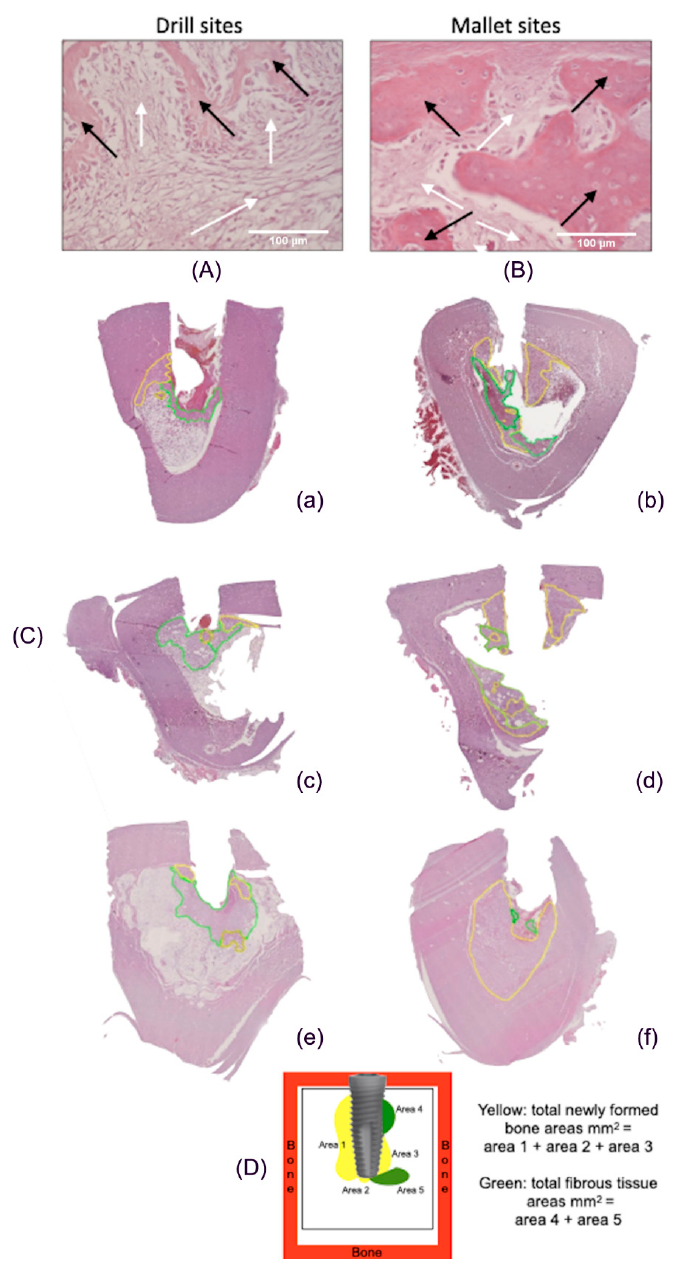
Figure 4. Histological images of peri-implant tissues and scheme of area calculation. ( A ) The fibrous tissue (white arrows) was greater than newly formed bone tissue (black arrows) in drill-prepared sites (Hematoxylin and Eosin, 400×). ( B ) In the mallet site, the amount of newly formed bone tissue (black arrows) is greater than that of fibrous tissue (white arrows) (Hematoxylin and Eosin, 400×). ( C ) Areas of new bone and fibrous tissue deposition, expressed as total surface (mm 2 ), using an imaging computer software, according to the Han, J.-M. et al. [19] protocol. In every picture, in yel- low, areas of new bone deposition and in green, areas of fibrous tissue. ( a , c , e ): tissues from sites prepared with drill technique, in the three different animals; ( b , d , f ): tissues from sites prepared with mallet technique in the three different animals. The bone samples obtained from mallet sites show a greater area of newly formed bone and a lower area of fibrous tissue compared to drill ones. ( D ) Example of scheme for calculating the newly formed bone and fibrous tissue around the implants.